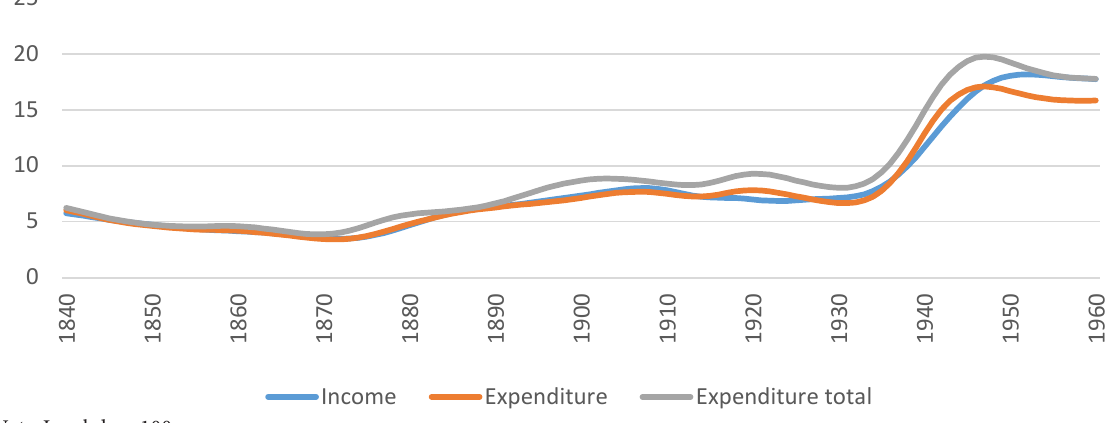
Figure 4. HP-trend of central government sector income and spending in percent of GDP,